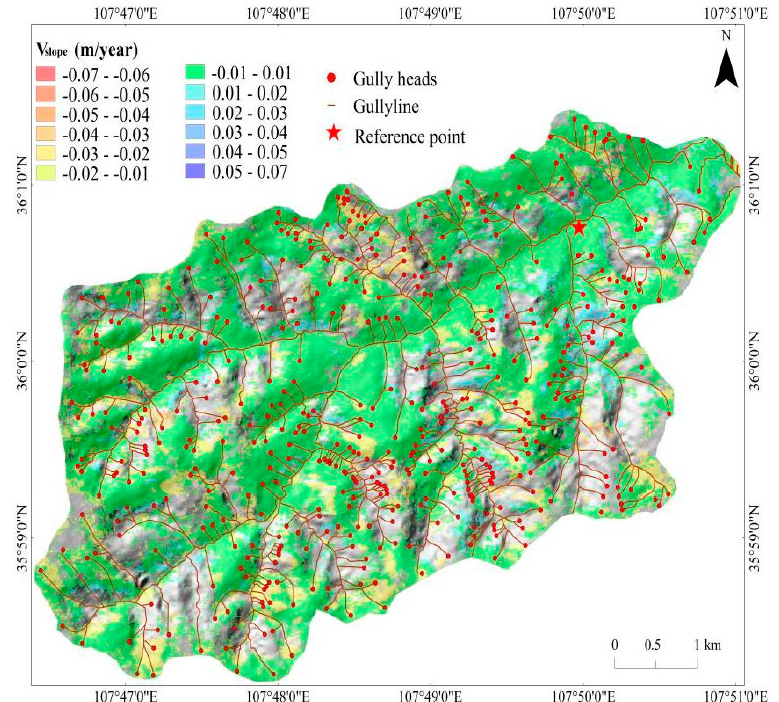
Figure 12. Deformation along the slope derived by SBAS-InSAR in the research area.